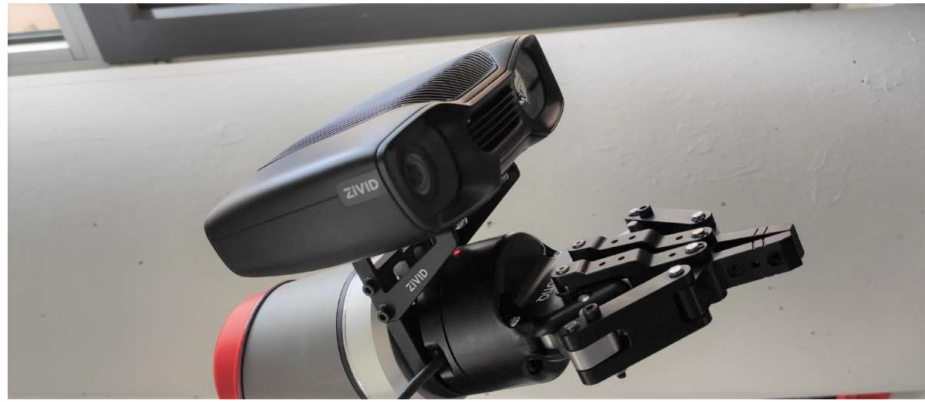
Figure 7. Zivid Two with projector (left) and 2D camera (right) mounted on a robot